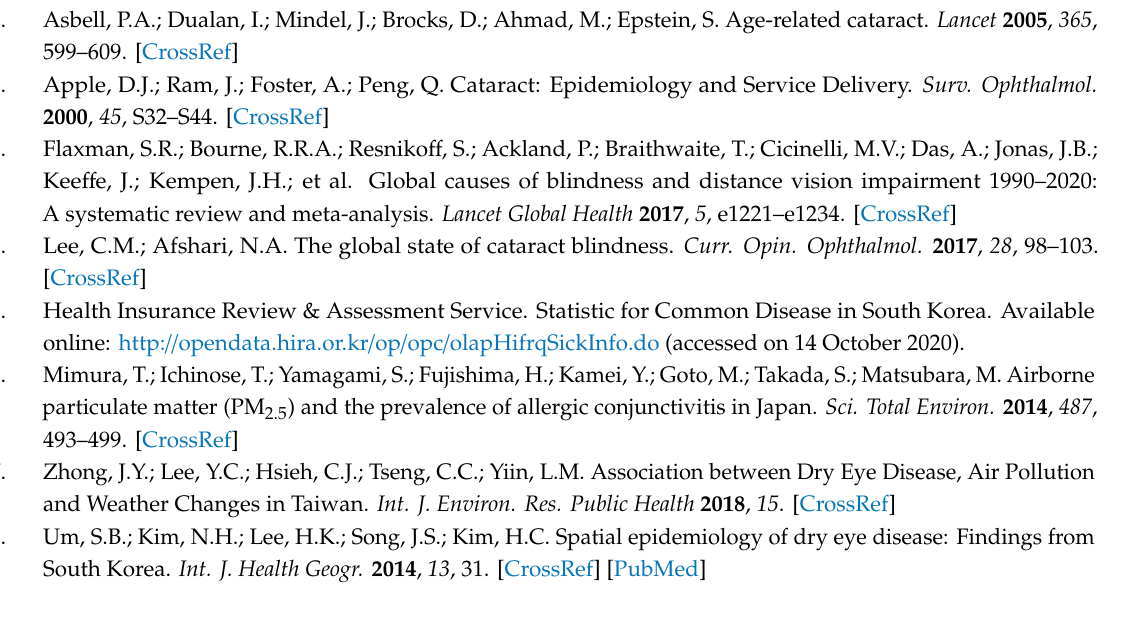
Table S1: The air pollutants and meteorological data in Korea from 2002–2015. Particulate matter < 10 µ m (PM 10 ), Sulfur dioxide (SO 2 ), Nitrogen dioxide (NO 2 ), Carbon monoxide (CO) and Ozone (O 3 ) were measured between 2002–2015. Particulate matter < 2.5 µ m (PM 2.5 ) was measured in 2015. Temperature, rainfall and wind speed were shown at Seoul (Lat.(N) 37 ◦ 34 (cid:48) , Long.(E) 126 ◦ 57 (cid:48) ). Korea Meteorological Administration, Seoul,